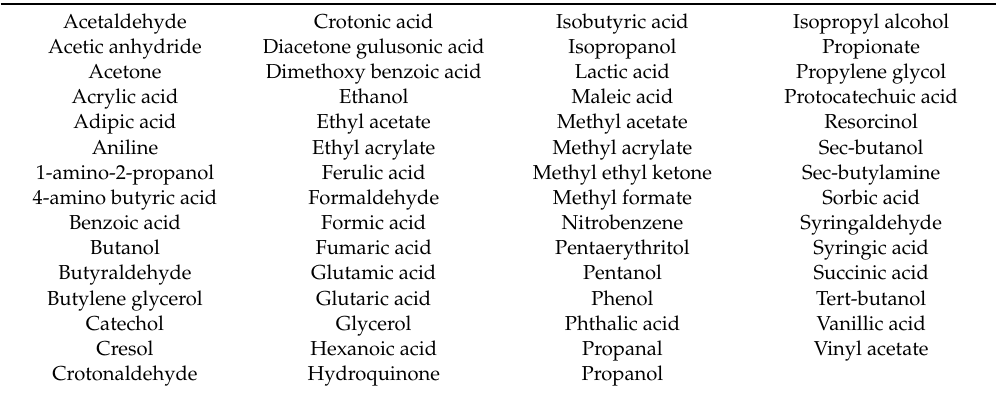
Table 2. Chemical compounds amenable to anaerobic biotechnology.